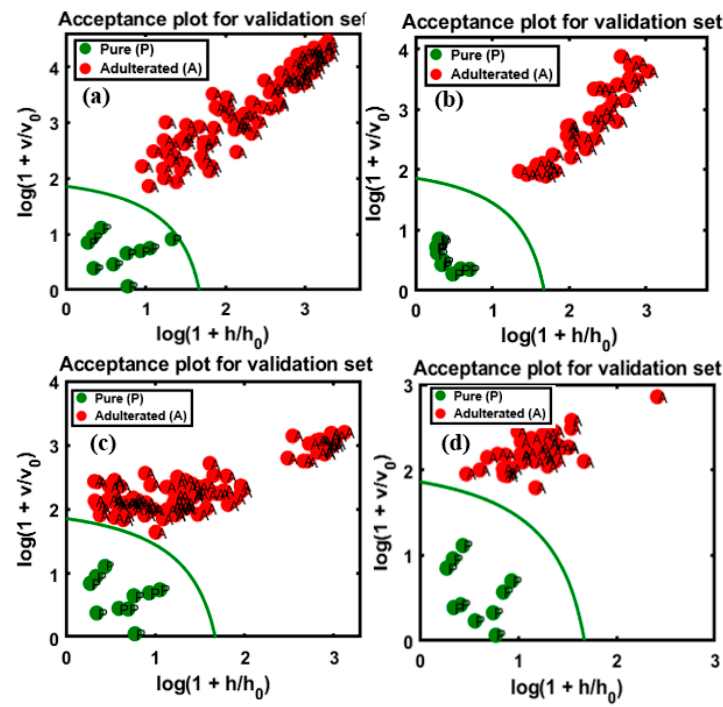
Figure 9. Prediction performance of the model with respect to the chi-square acceptance area of class